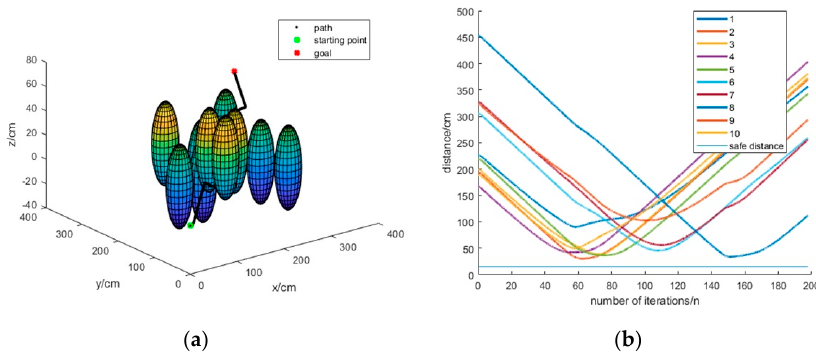
Figure 12. Case without time step in group 1. ( a ) Path planning of 3D map. ( b ) The distance from obstacles.